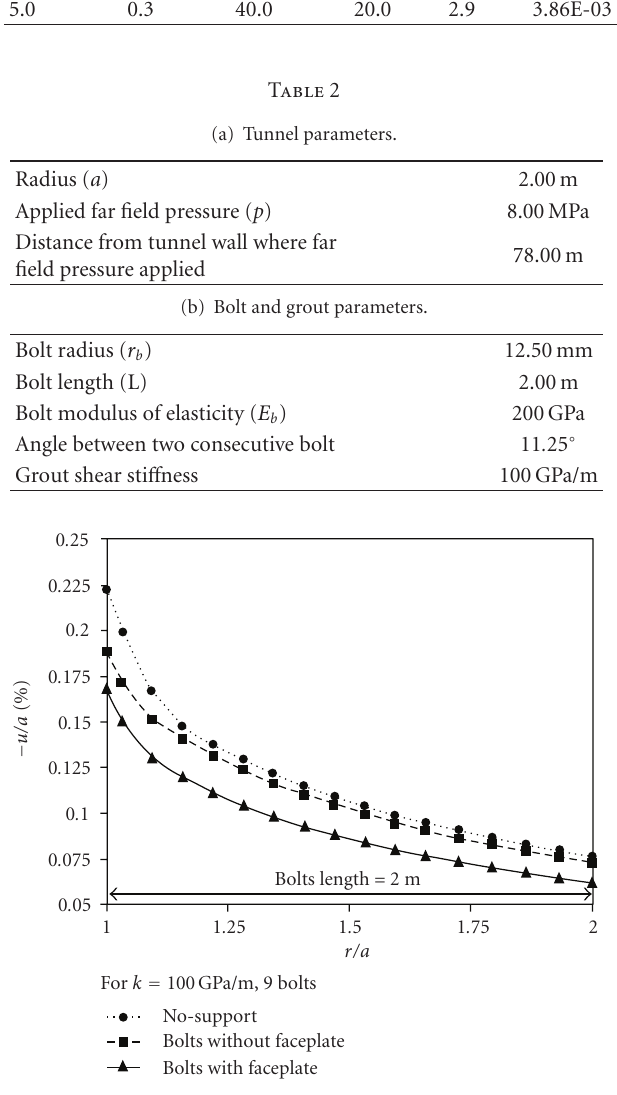
Figure 9: Distributions of radial displacements in rock mass around the tunnel boundary.